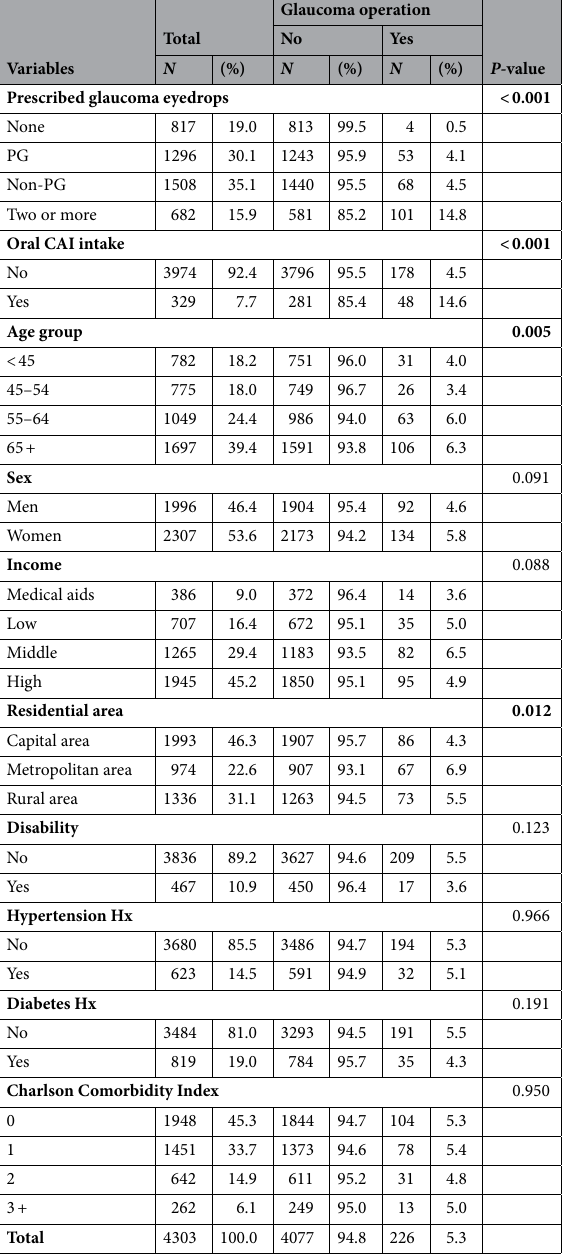
Table 1. General characteristics of study population. PG: Prostaglandin analogue; CAI: Carbonic anhydrase inhibitor; Hx: History, * P -values were calculated using Chi-square test. Indicated in bold type, P < 0.05 indicates statistical